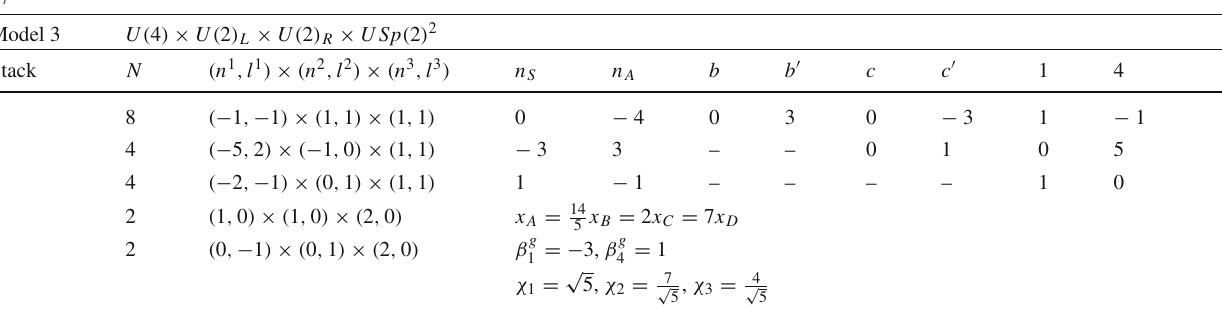
= 7 ( 5 ) g 2 g 2 c = 35 g 2 b Y 6 6 32 3